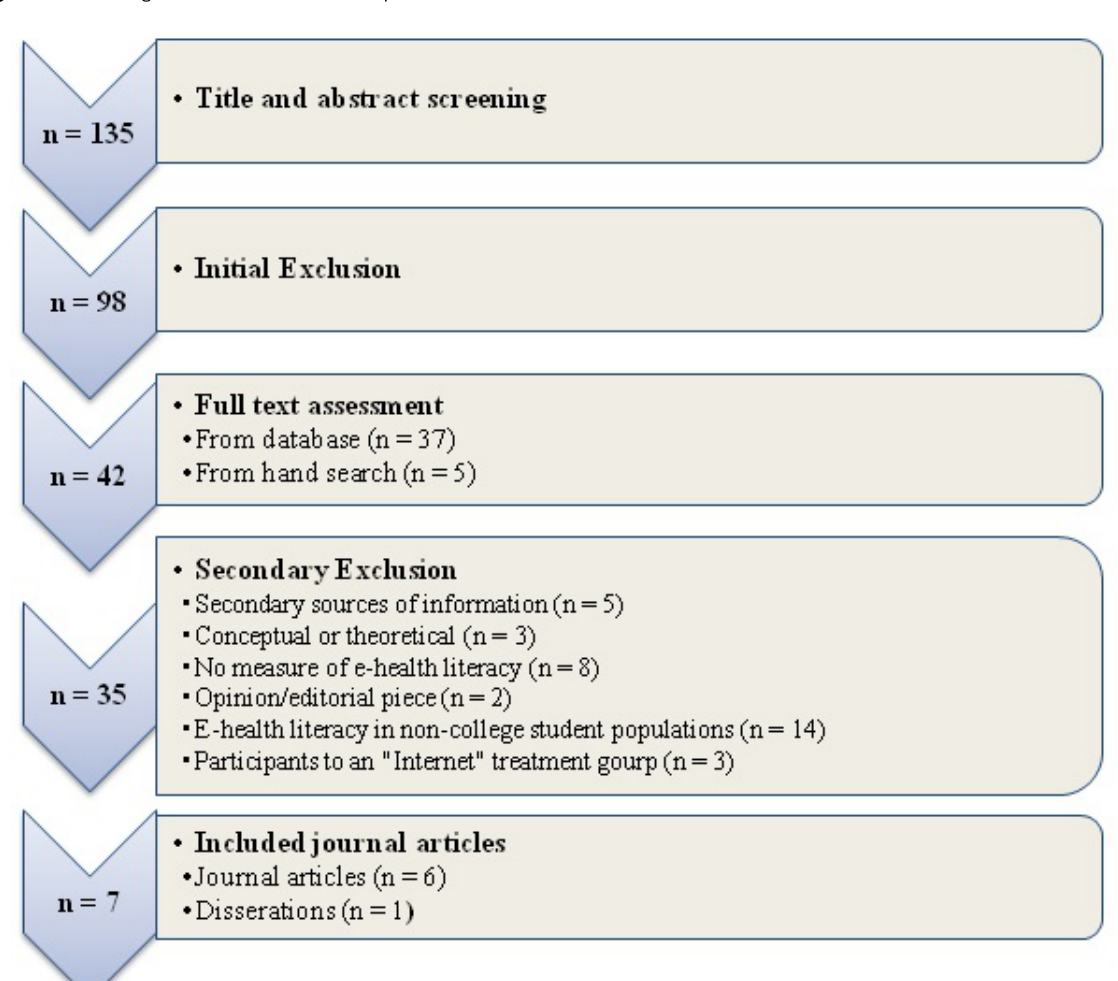
Figure 1. Flow diagram of the article selection